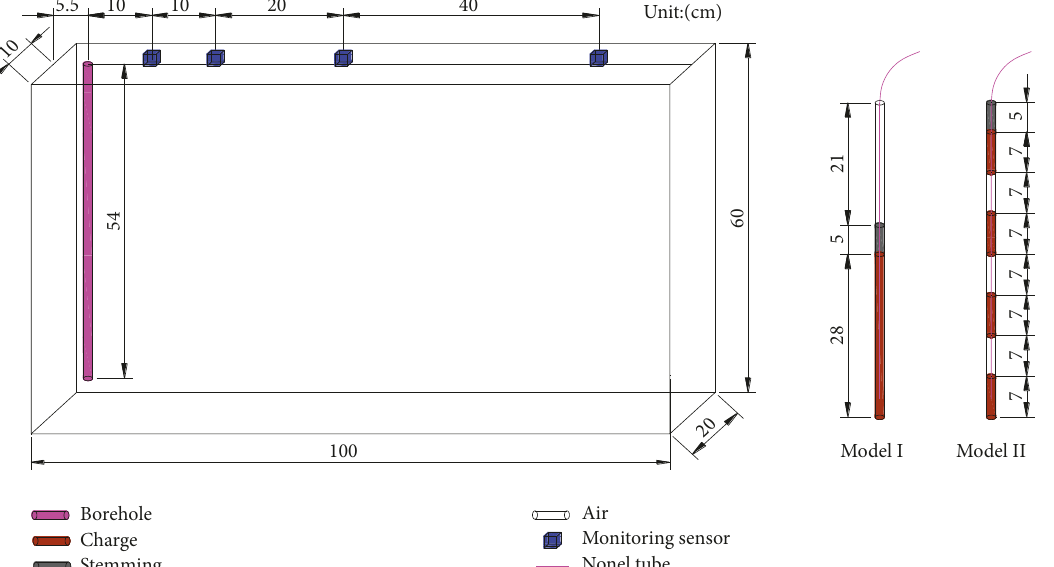
Figure 16: The cement mortar models and layout of vibration measuring points.